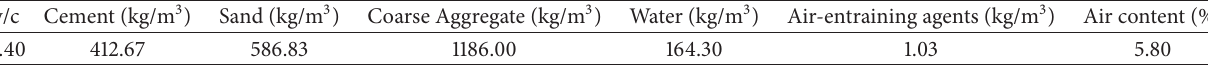
Table 1: Mix proportions of air-entrained